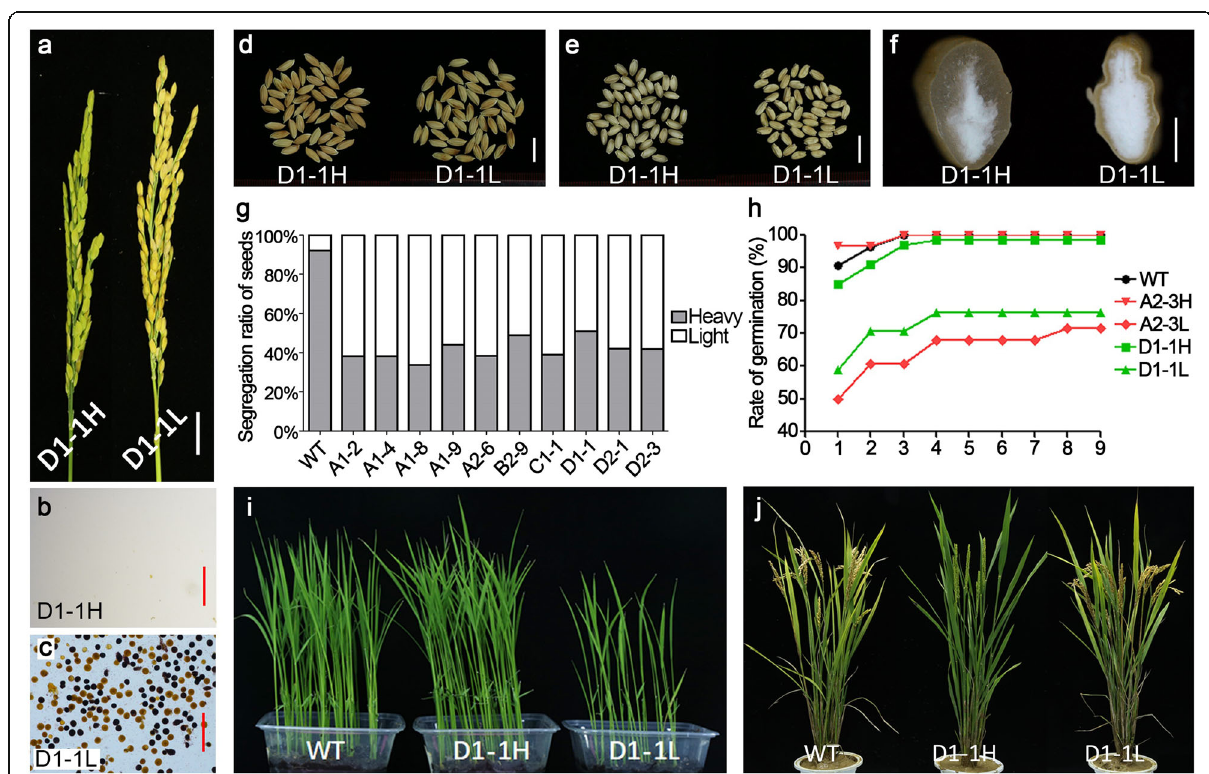
Fig. 4 Characteristics of the T 1 and T 2 generations. Panicles ( a ) and pollen fertility ( b, c ) of the T 1 plants derived from the heavy seed and light seed harvested from the D1-1 T 0 transgenic plant. The T 2 seeds harvested from the T 1 generation plants were divided into heavy-weight and light-weight groups and examined for grain out-appearance ( d ), de-hulled grains ( e ), cut endosperms ( f ), rates of heavy and light grains ( g ), seed germination ( h ), vigor of seedling growth ( i ), and appearance of mature plants ( j ). Pollen grains were stained with 1% I2-KI solution. Results from D1-1 plant were shown as a representative. Bar: (a) = 2 cm; (b, c) = 200 μ m; (d, e) = 1 cm; f = 1